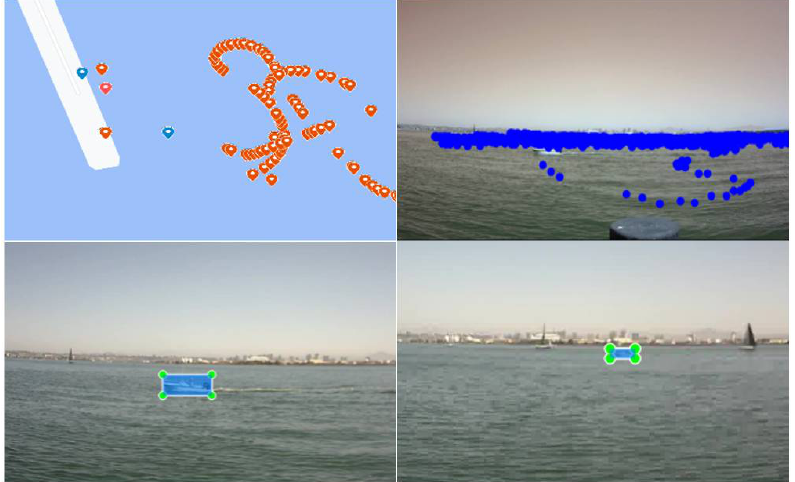
Figure 1. Boat detection and localization: ( top left ) GPS coordinates of the training set, ( top right ) aggregated boat locations, ( bottom ) two image frames with the detected boat.